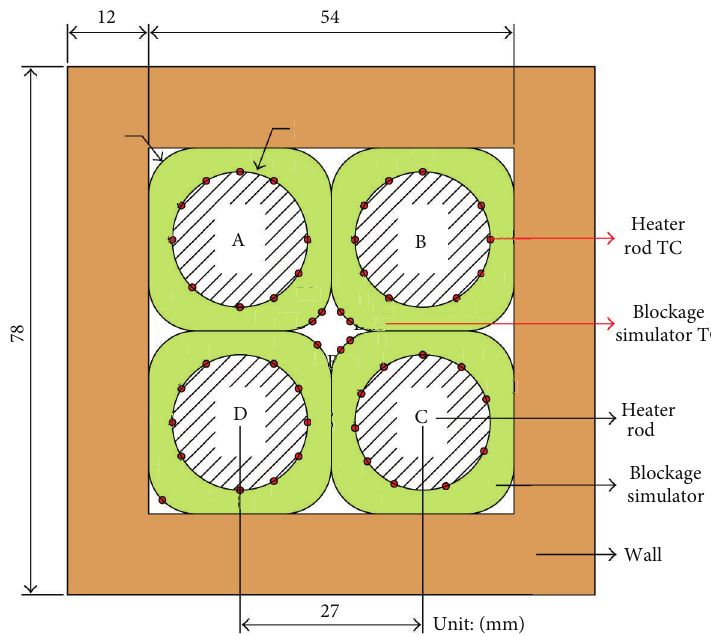
Figure 4: Radial TC locations of the test